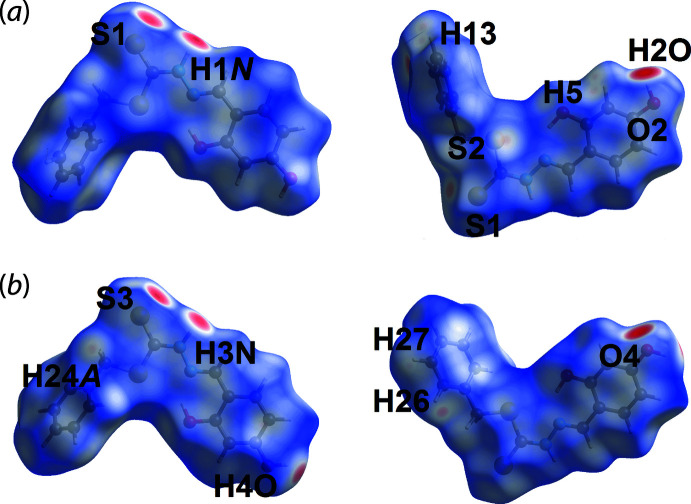
Views of the Hirshfeld surface for (I) mapped over d
norm for the (a) S1-containing mol­ecule and (b) S3-mol­ecule. The surfaces were mapped in the range −0.572 to +1.067 arbitrary units.